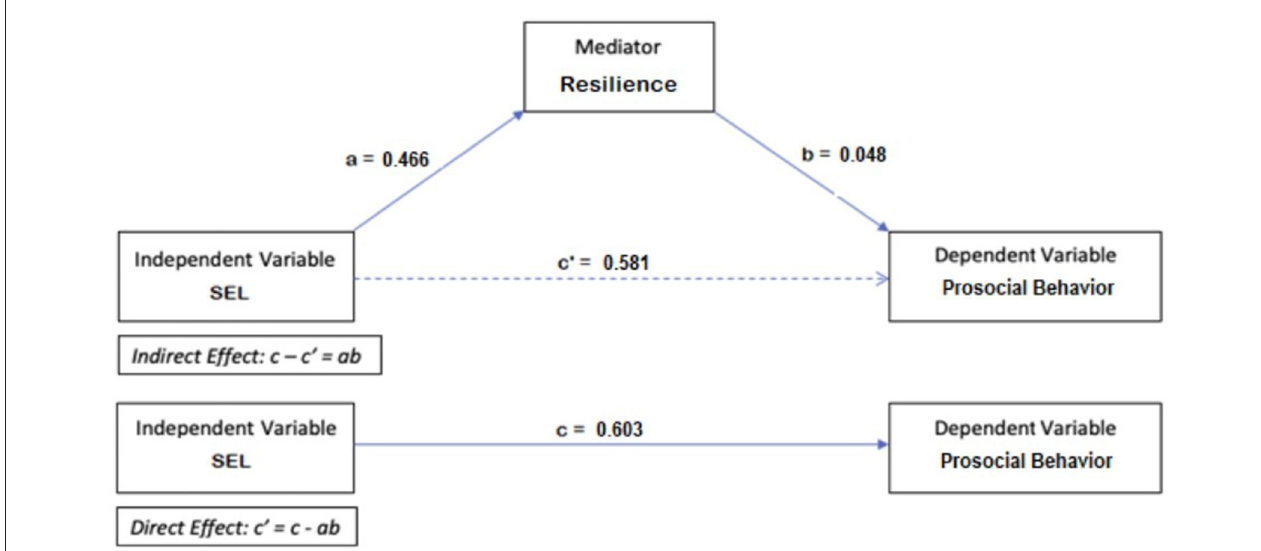
FIGURE 3 | Mediation model for prosocial